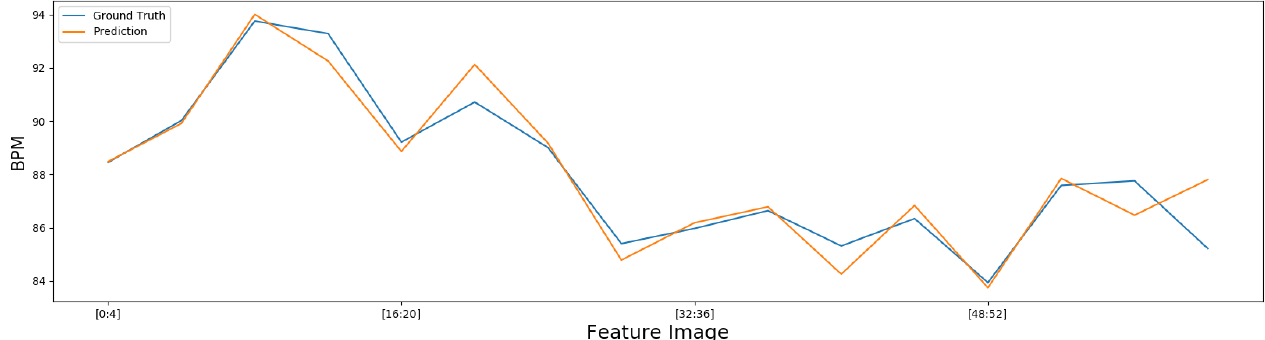
Figure 8. BPM prediction of subject 49 from dataset UBFC.